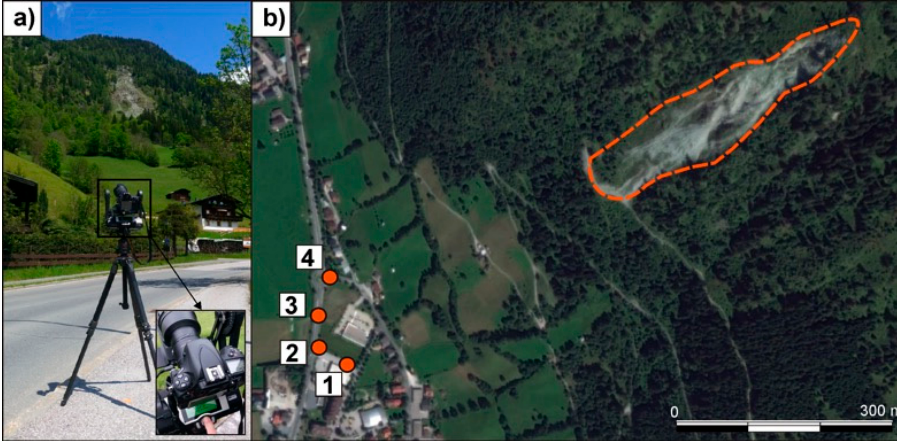
Figure 3. ( a ) GigaPan equipment used; and ( b ) location of the GigaPan surveying points (base map: Google Earth, Image 2016 Digital Globe).